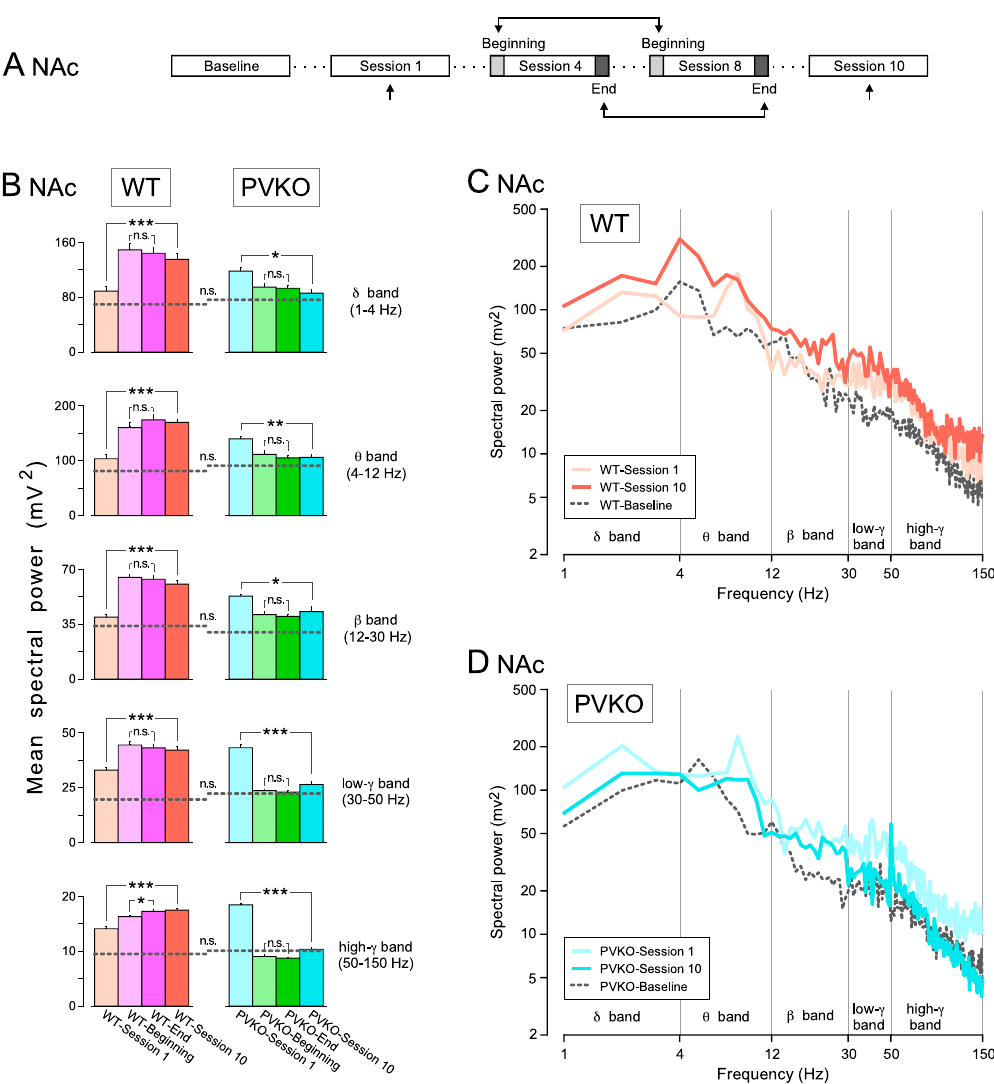
Figure 7. Spectral analyses of LFPs recorded in the NAc across the successive operant conditioning sessions. ( A ) Experimental design. ( B ) Power histograms for the five selected frequency bands of LFPs recorded in the NAc from WT (orange and pink) and PVKO (blue and green bars) mice during the 1st session , at the beginning of the 4th–8th sessions , at the end of the 4th–8th sessions and during the 10th sessions . Differences between the spectral powers in the selected frequency bands are indicated at the enclosed histograms for both WT and PVKO mice. The dotted lines across the histograms of each frequency band correspond to the mean power of the baseline condition for the corresponding group of mice. Note the larger spectral powers presented by LFPs collected from WT mice for the five selected frequency bands. Tukey-Kramer multiple comparisons test: n.s., non-significant difference; * P < 0.05 ; ** P < 0.01 ; *** P < 0.001 (for details see Supplementary Tables S5.1-S5.3). ( C ) Mean power spectra of LFPs recorded in the NAc from WT mice during the baseline condition and during the 1st session (light orange trace) and during the 10th session (dark orange trace). ( D ) Mean power spectra of LFPs recorded in the NAc from PVKO mice during the baseline condition and during the 1st session (light blue trace) and during the 10th session (dark blue